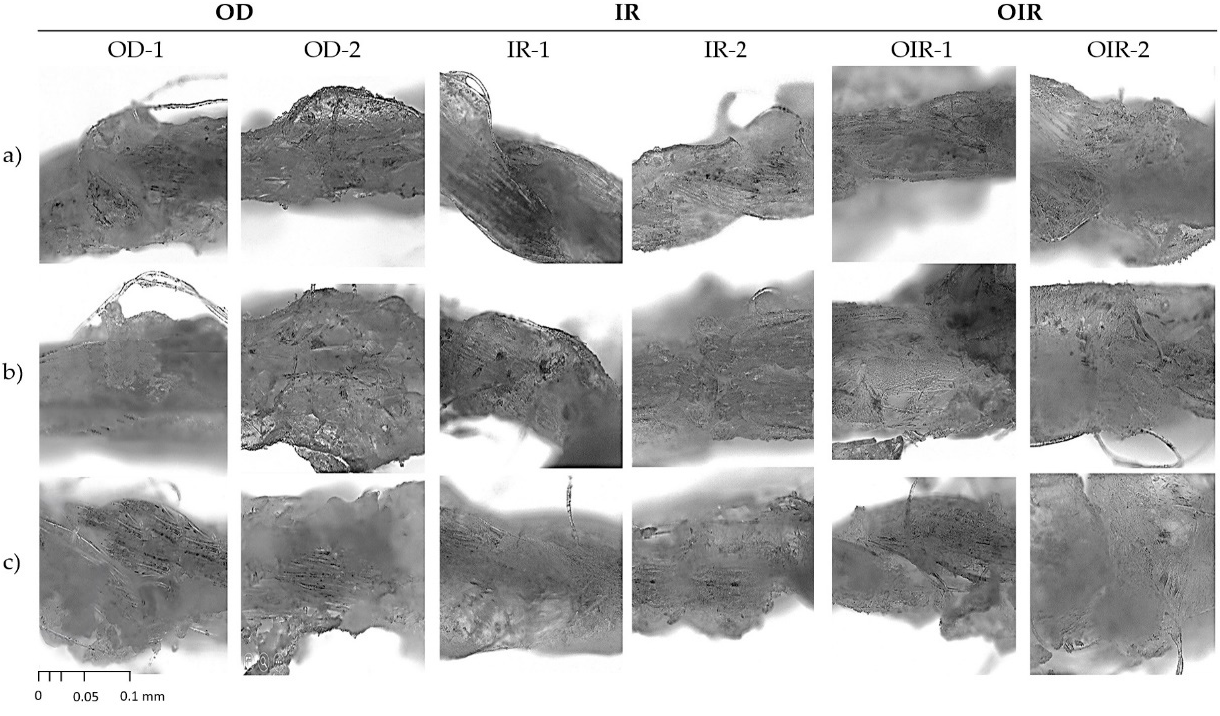
Figure 5. Observation under an optical microscope of a single coat (OD-1, IR-1, and OIR-1) and double coat (OD-2, IR-2, and OIR-2) cross-linked with ( a ) 2M CA, ( b ) 3M CA, and ( c ) 4M CA under different drying regimes with a scale at 0.1 mm.